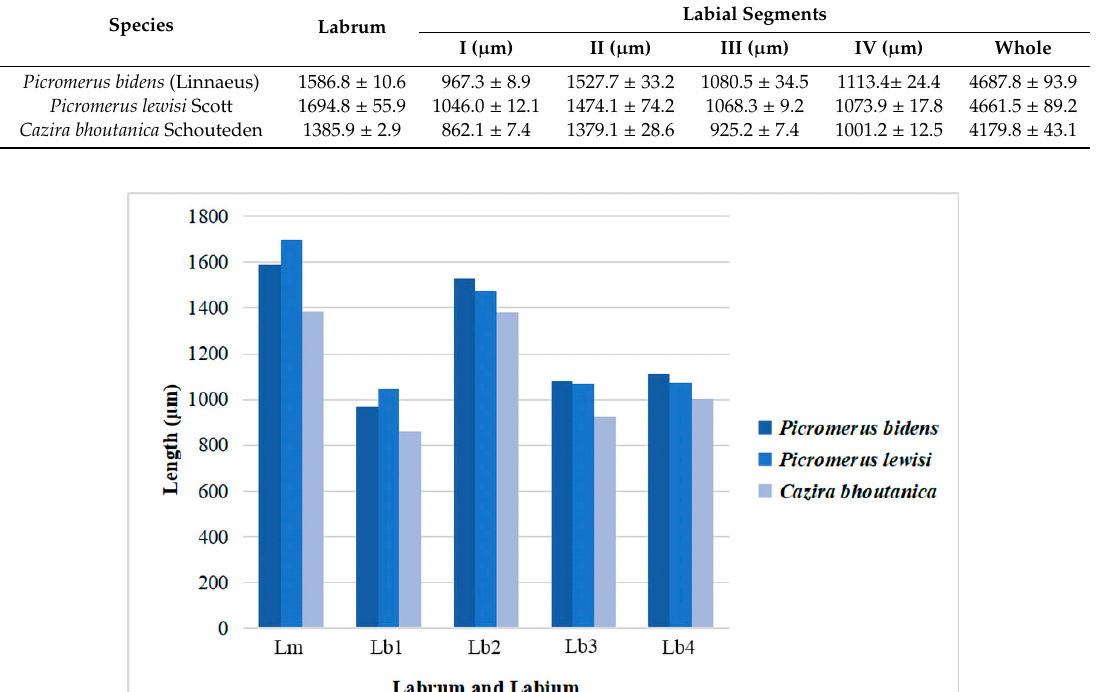
Table 1. Comparison of the lengths of labial segments in studied species. Data are means ± SE values obtained from scanning electron microscopy.